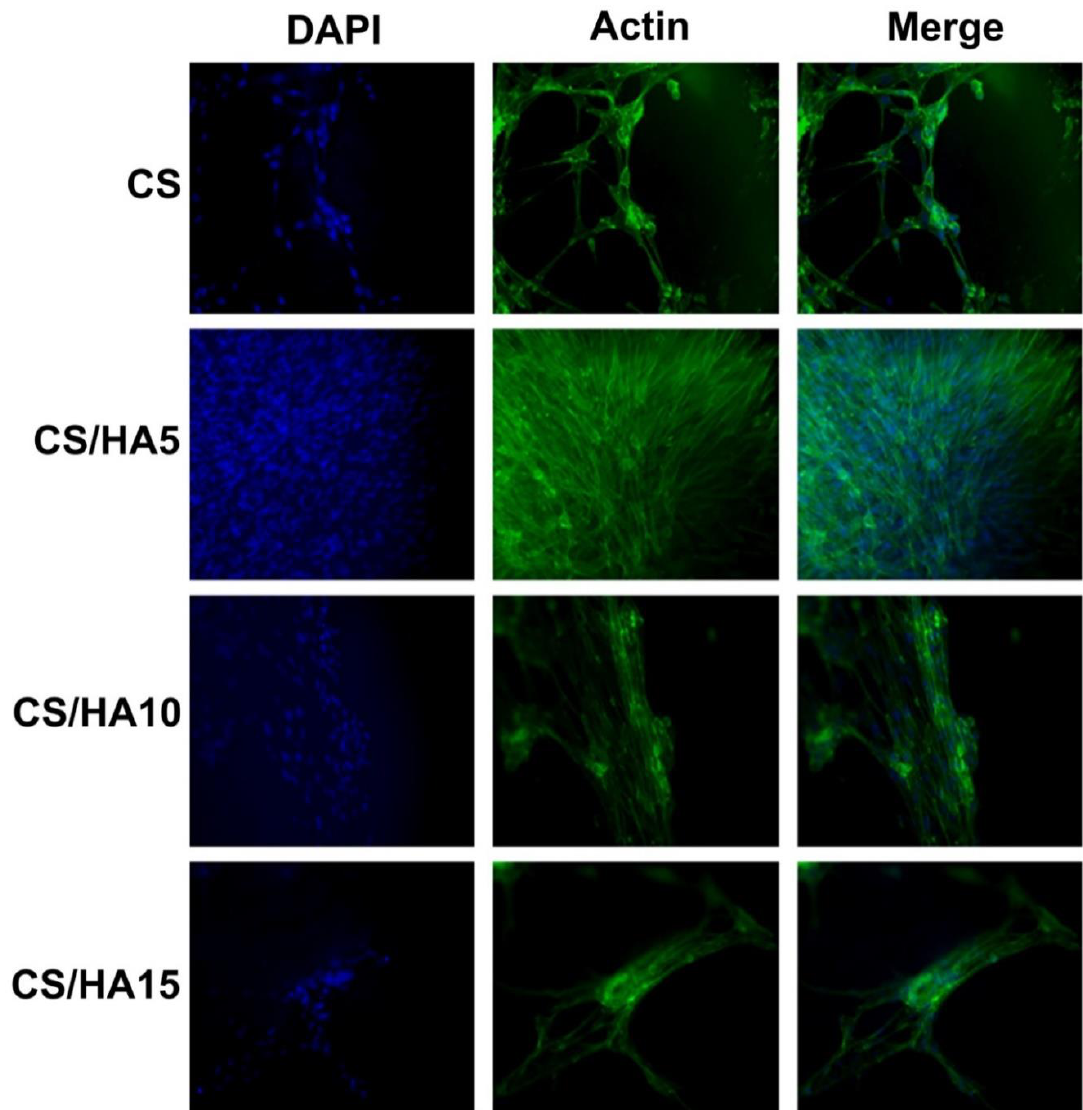
Figure 9. Immunofluorescence detection of fibroblasts grown onto CS, CS / HA5, CS / HA10 and CS / HA15 films. Bar = 100 µ m.